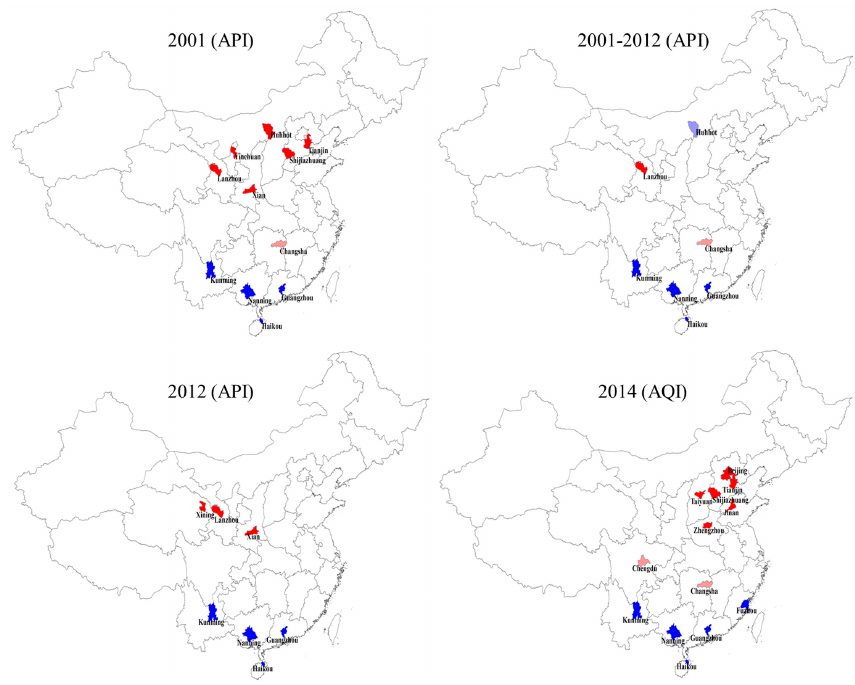
Figure 5. The local spatial autocorrelation of the API and AQI. The bright red represents “high-high” clusters; the deep blue represents “low-low” clusters; the light red represents “high-low” clusters; and the light blue represents “low-high” clusters.